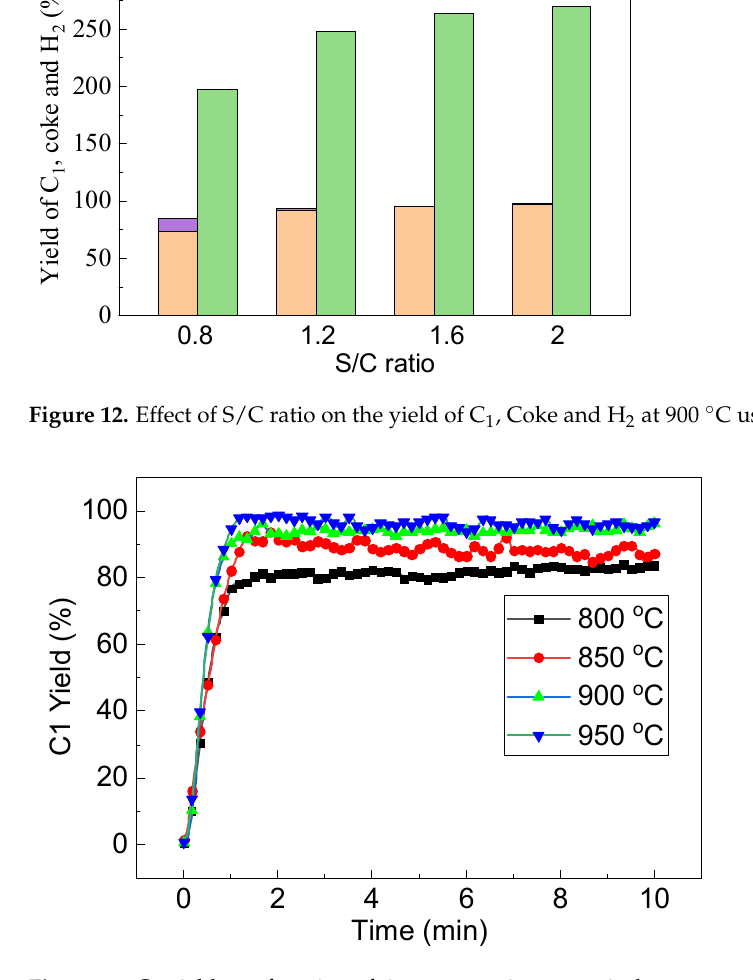
Figure 13. C 1 yield as a function of time versus time at typical temperature and S/C = 1.6.